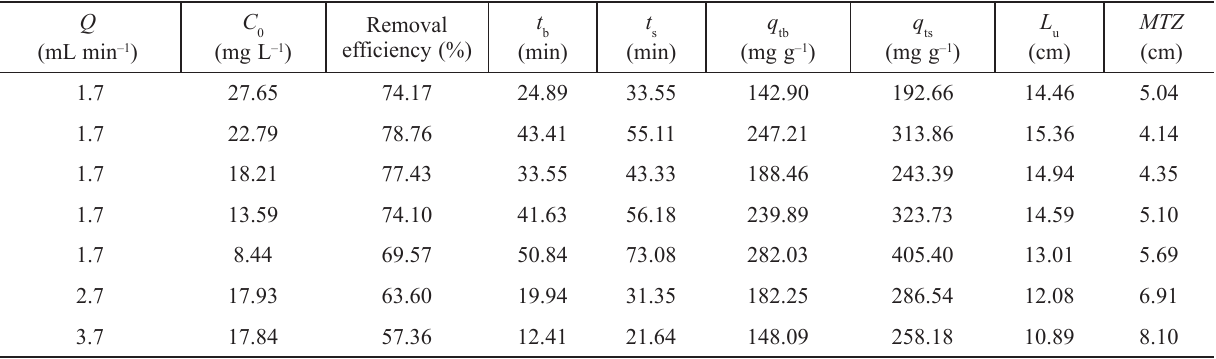
Table 4 – Calculations of removal efficiency and operating parameters of the breakthrough curves